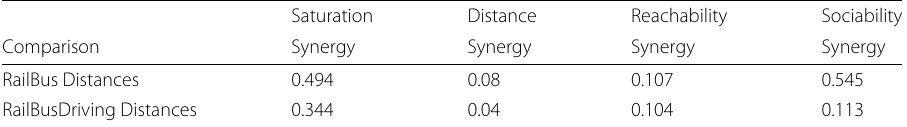
Table 8 R 2 of linear fit models predicting the synergy score from the distances to each relevant